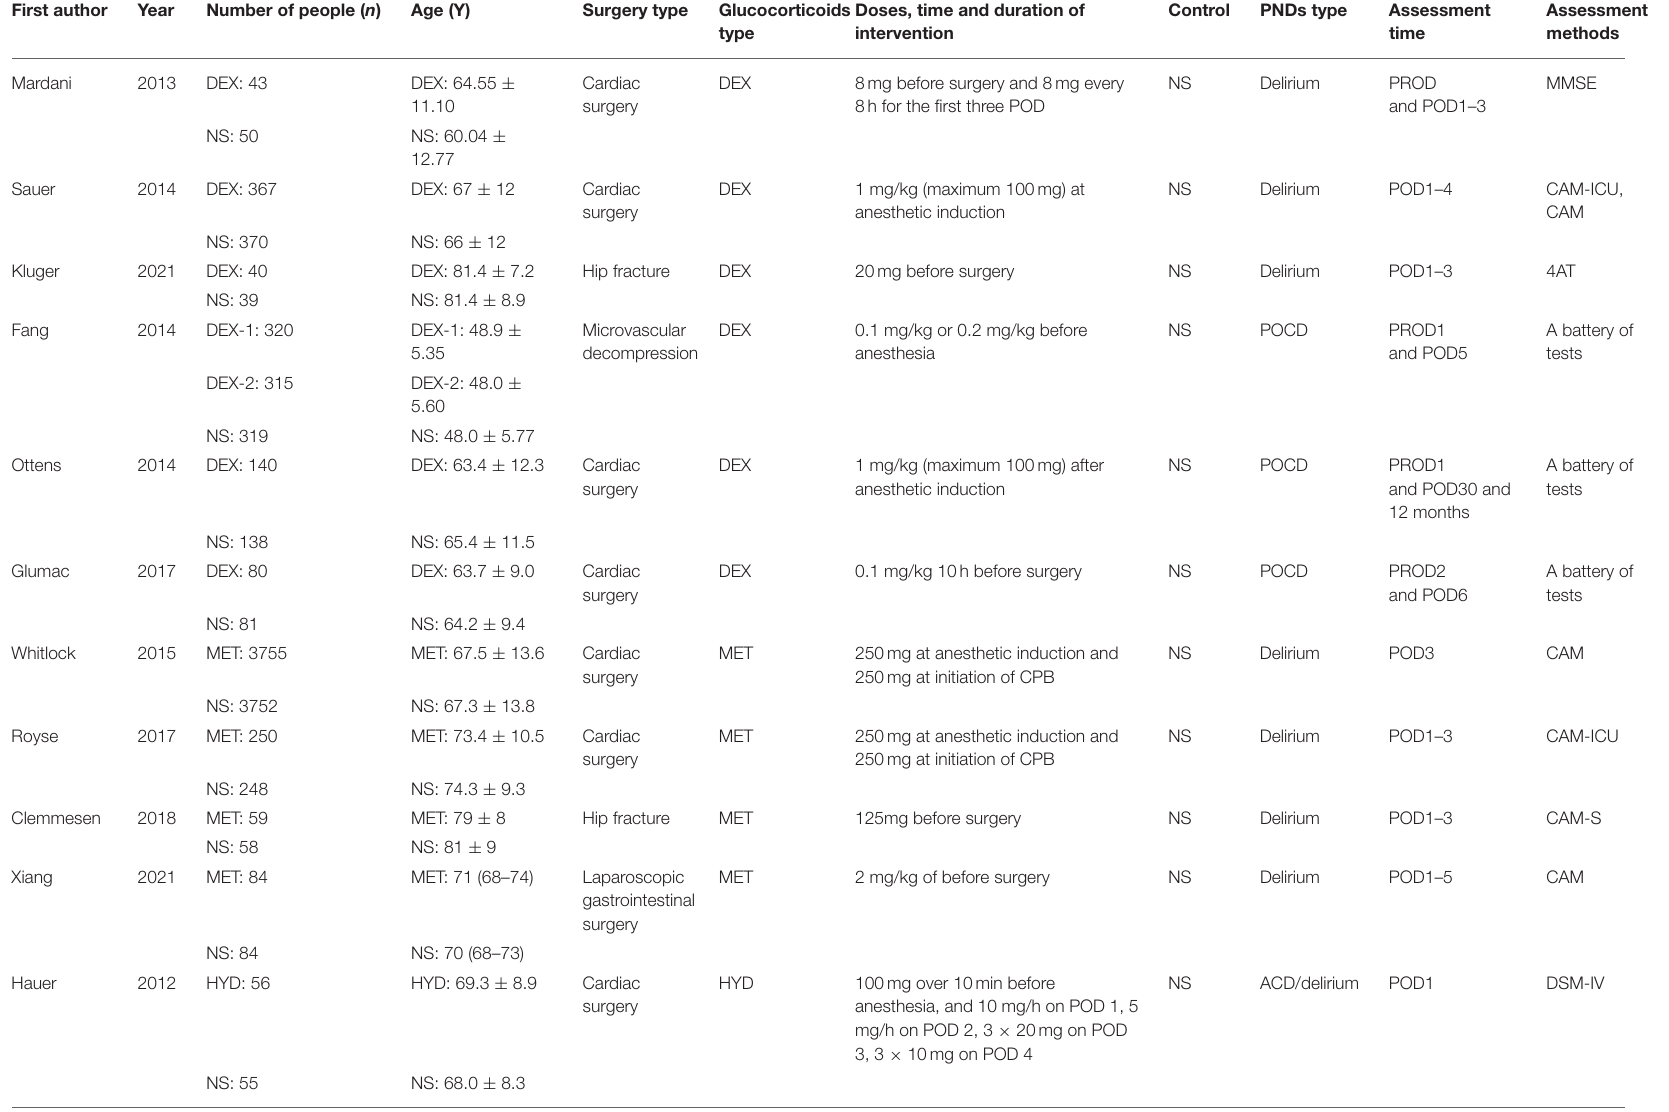
TABLE 1 | Characteristics of the 11 included